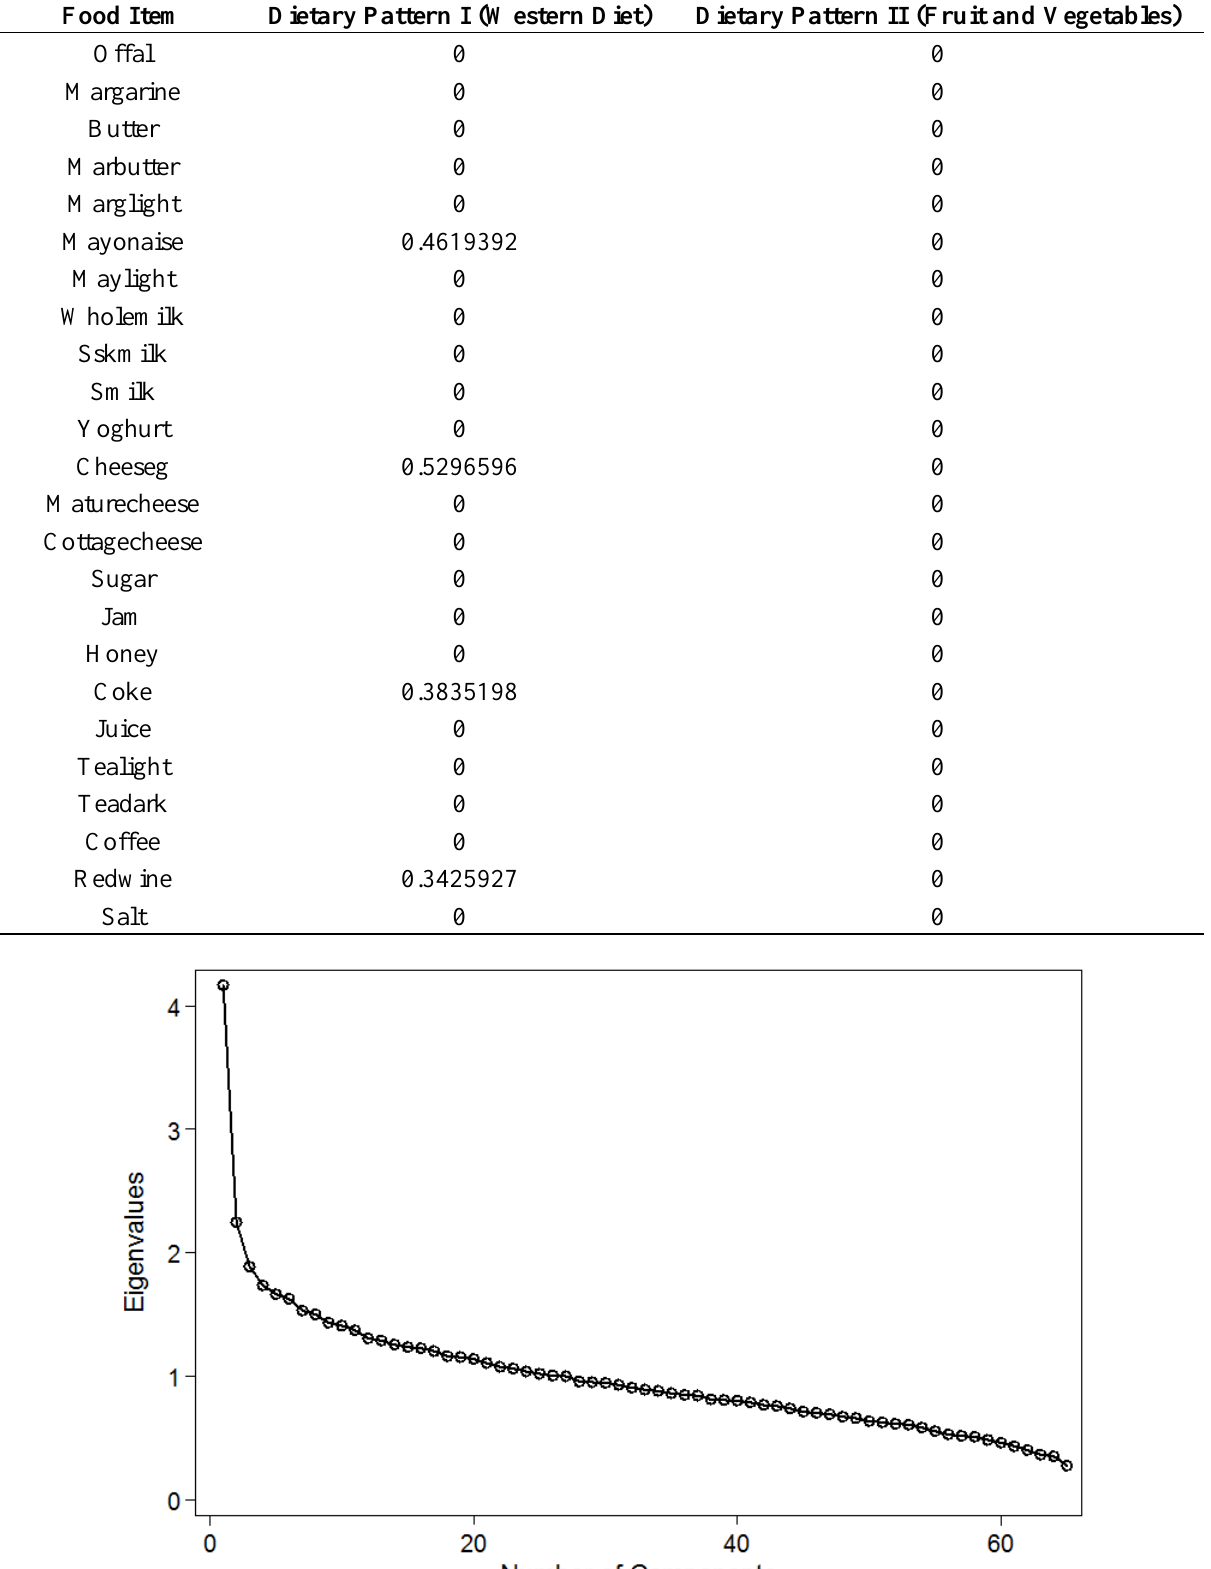
Figure A1. Scree plot of PCA for dietary patterns